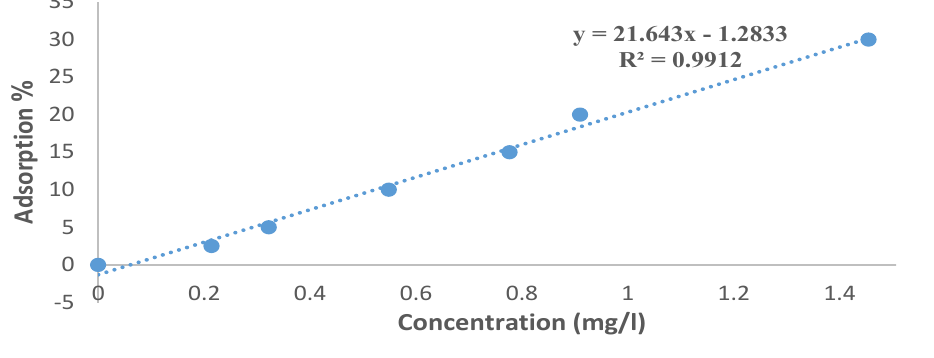
Figure 2. Calibration curve to determine the methyl orange dye concentration To evaluate the results obtained from the optimization of various parameters, the percentage of color output was calculated using equation1, and